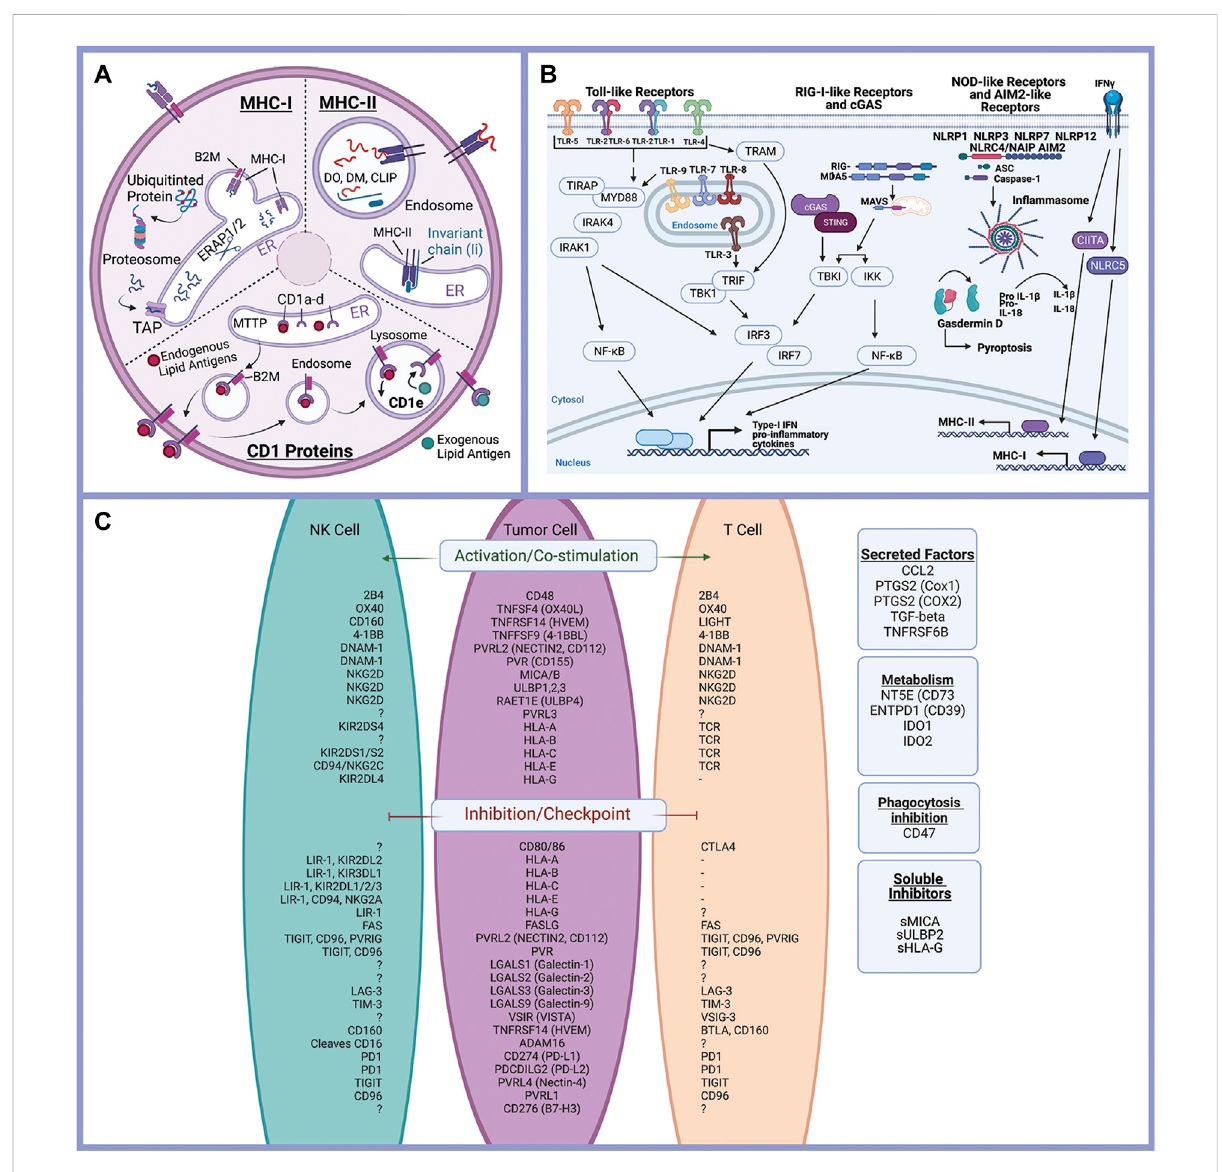
FIGURE 2 Epithelial cells and the immune response. Antigen processing and presentation of peptide antigens and lipid antigens occurs in malignant epithelial cells and alters the anti-tumor immune response (A) . Innate immune receptor signaling is triggered by a variety of ligands triggering expression of in fl ammatory mediators and activation of pyroptosis (programed cell death) (B) . Immune modulating proteins including checkpoint ligands, co-stimulatory molecules, and suppressive tumor cells regulate the anti-tumor immune response (C) . Created with